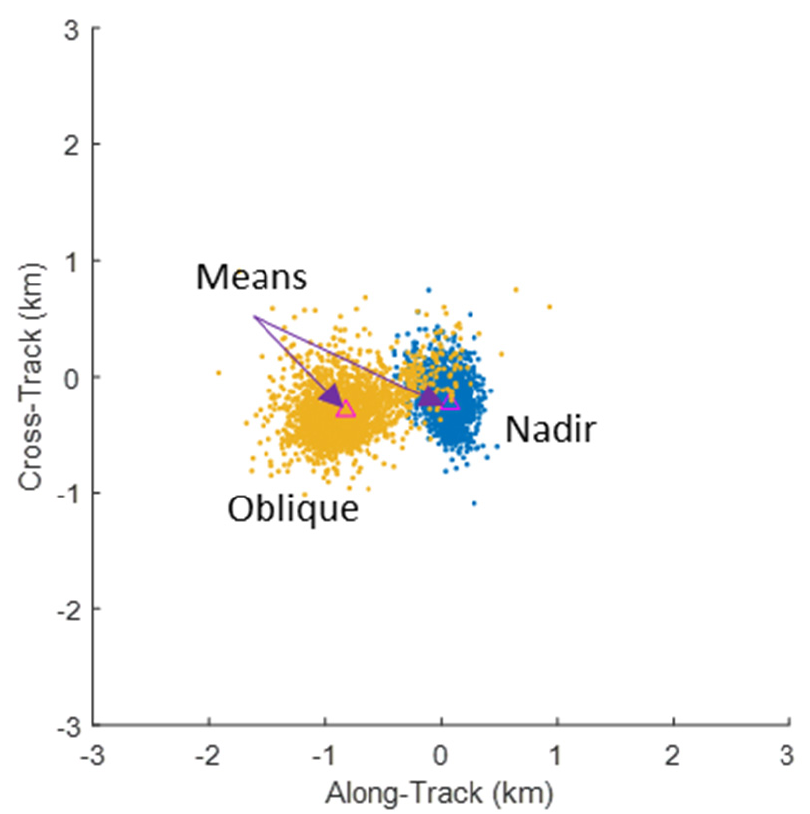
Figure 8. A population of LWIR ground-point disparities for a Terra-S3B overpass (21 December 2021 19:14Z) clearly shows the relative registration error between the SLSTR nadir and the oblique scenes and MODIS. The nominal ground sample distance is 1 km, so the deregistration is no more than 1 pixel.